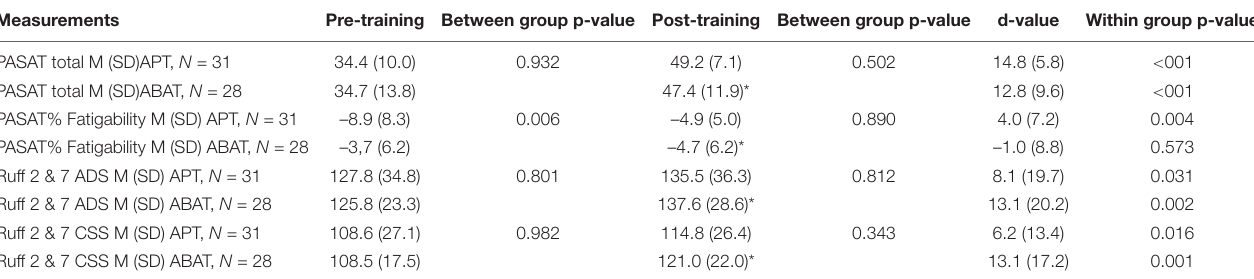
TABLE 2 | Values pre-training and post-training for the Attention Process Training group (APT) and the Activity-Based Attention Training group (ABAT) on neuropsychological measurements. Measurements Pre-training Between group p-value Post-training Between group p-value d-value Within group p-value